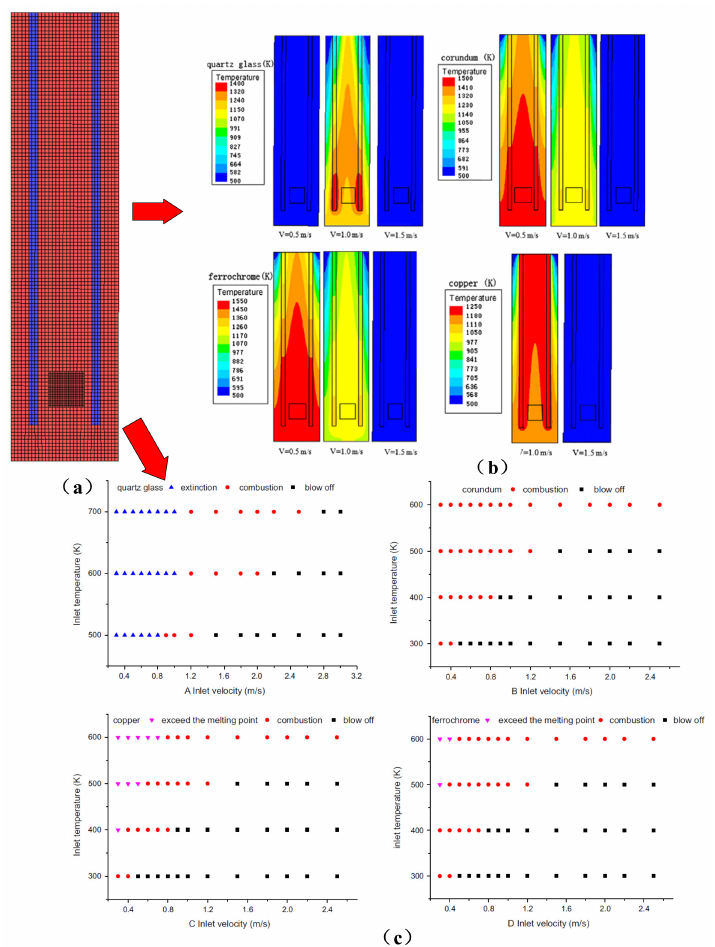
Figure 10. Combustor grids, stable combustion limit, and temperature distribution. ( a ) Combustor grids, ( b ) Temperature distribution, ( c ) Stable combustion